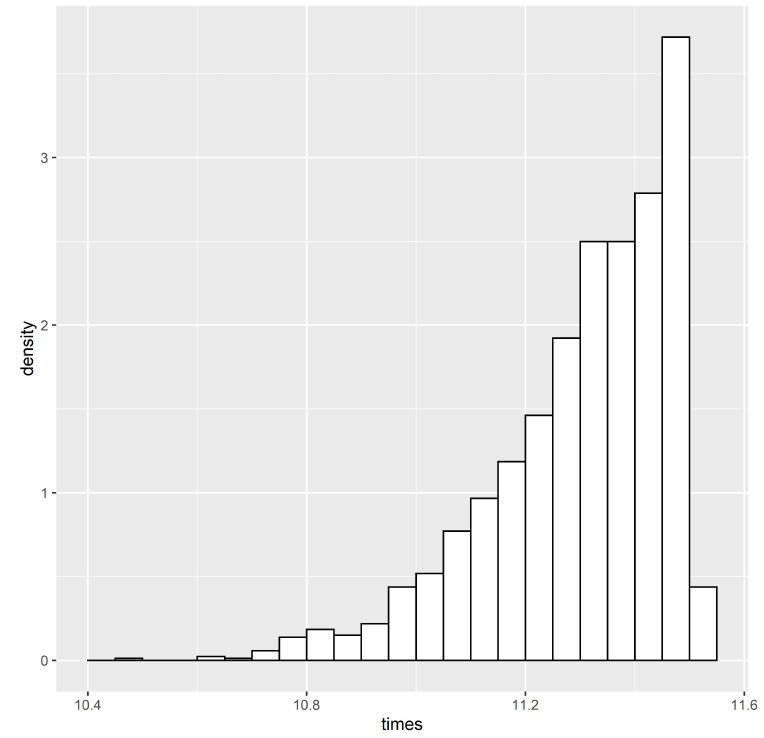
Figure 3. Histogram of the times of women’s 100 m in